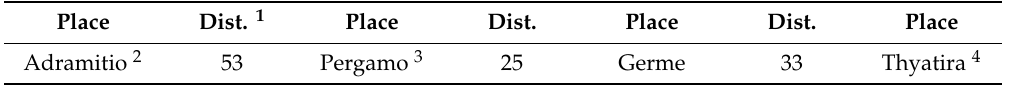
Table 1. Route through the study area mentioned in the Itinerarium Antonini .